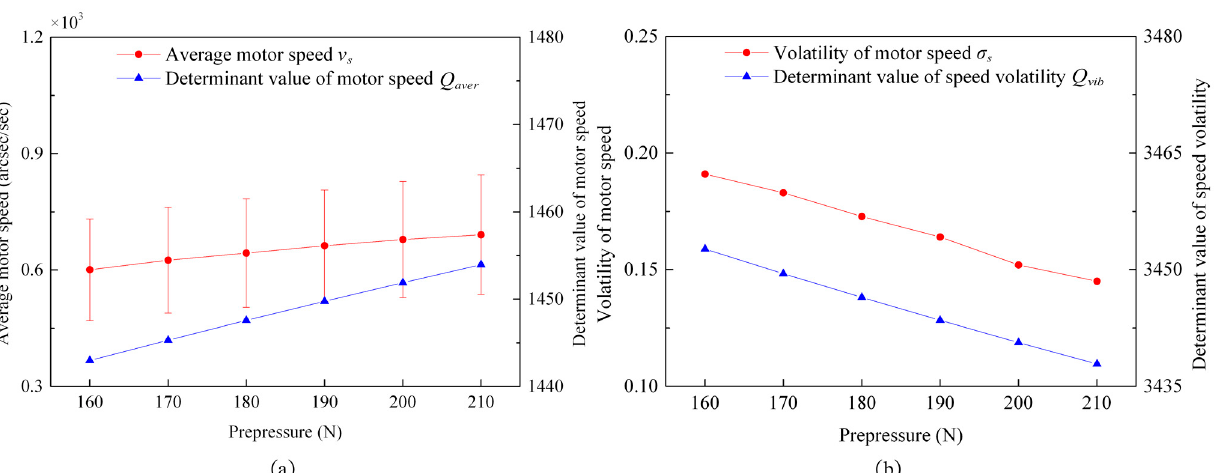
Figure 31. An experimental diagram of the variation trend of characteristic variables with prepressure: ( a ) an experimental diagram of the motor’s average speed, 𝑣 (cid:3046) , and the motor’s average speed determining factor, 𝑄 (cid:3028)(cid:3049)(cid:3032)(cid:3045) , with prepressure; and ( b ) an experimental diagram of the speed volatility, 𝜎 (cid:3046) , and the speed volatility determinant, 𝑄 (cid:3049)(cid:3036)(cid:3029) , with prepressure.